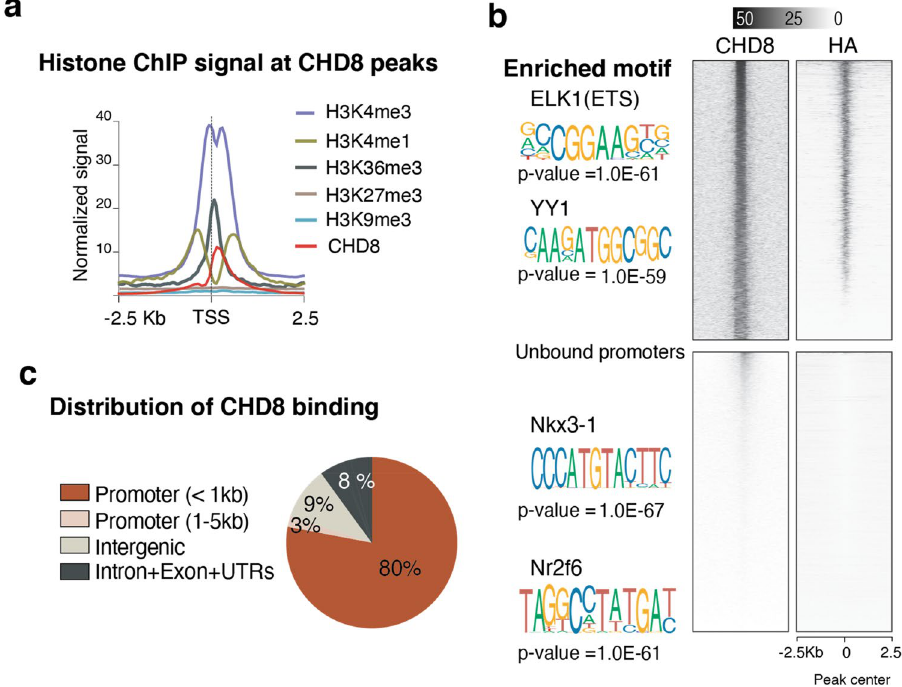
Figure 11. CHD8 binds to active promoters enriched with ELK1 motif. ( a ) CHD8 peaks overlapping with active histone modifications in neurons, (analysis of ENCODE data for H9 cell-derived neurons) 41 . ( b ) Top heatmaps are CHD8 binding at overlapping peaks between two separate pull-downs of HA and CHD8 antibodies (n = 3696 overlapping peaks). Using HOMER and MEME, we found ETS and YY1 motifs enriched at CHD8-bound sites. The bottom panels’ heatmaps are signals from the same samples that stratified on CHD8- unbound promoters (n = 4000). The greyscale shows normalized coverage for all groups 42,43 . ( c ) Pie chart shows the distribution of CHD8 ChIP-seq peaks across the genomic regions in ES cell-derived